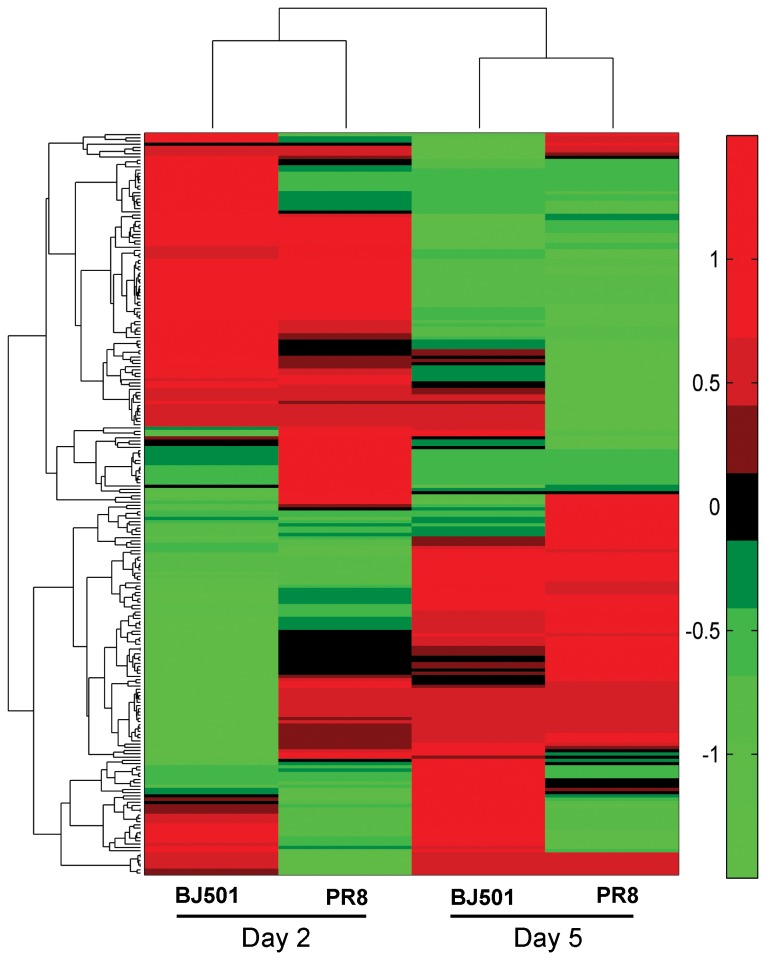
The microRNA expression patterns in response to influenza virus BJ501 and PR8 infections.The expression patterns of 230 detected microRNAs of influenza virus BJ501 and PR8 infections to the mock-infected controls on 2 dpi and 5 dpi were depicted with a clustered heatmap. The clustering tree is shown on the top and left sides. The red color represents up-regulation, while the green color indicates down-regulation.